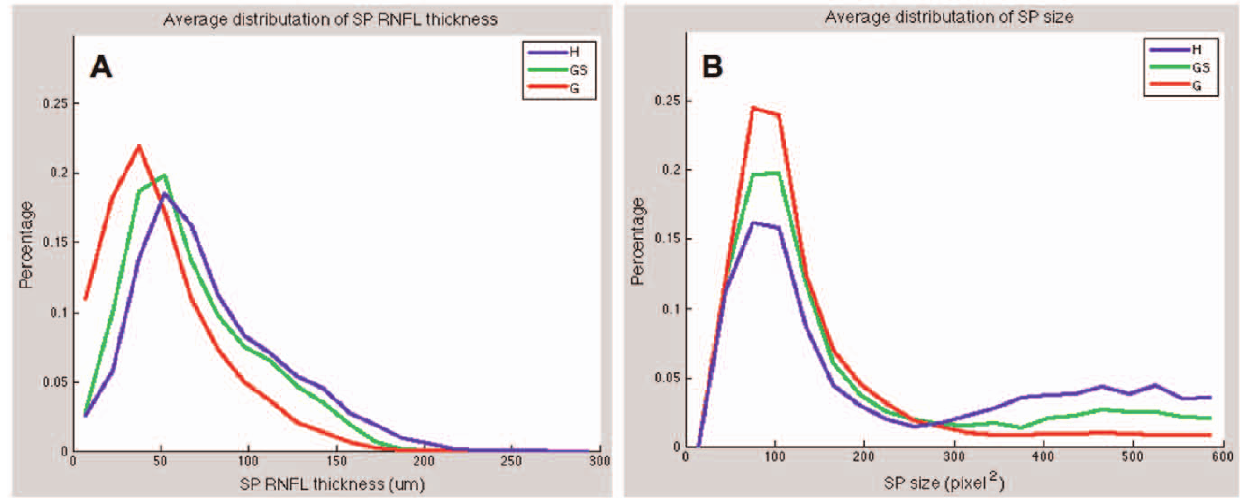
Figure 5. Normalized histogram distribution of super pixel. (A) RNFL thickness and (B) super pixel size for healthy (H), glaucoma suspect (GS), and glaucomatous (G) eyes.